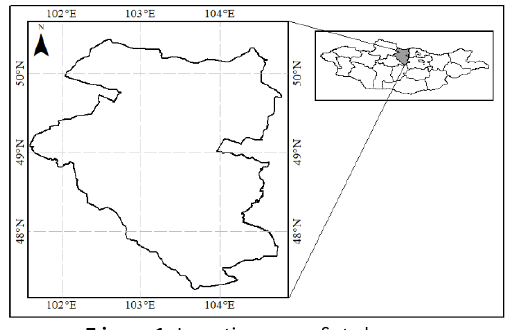
Figure 1. Location map of study area.